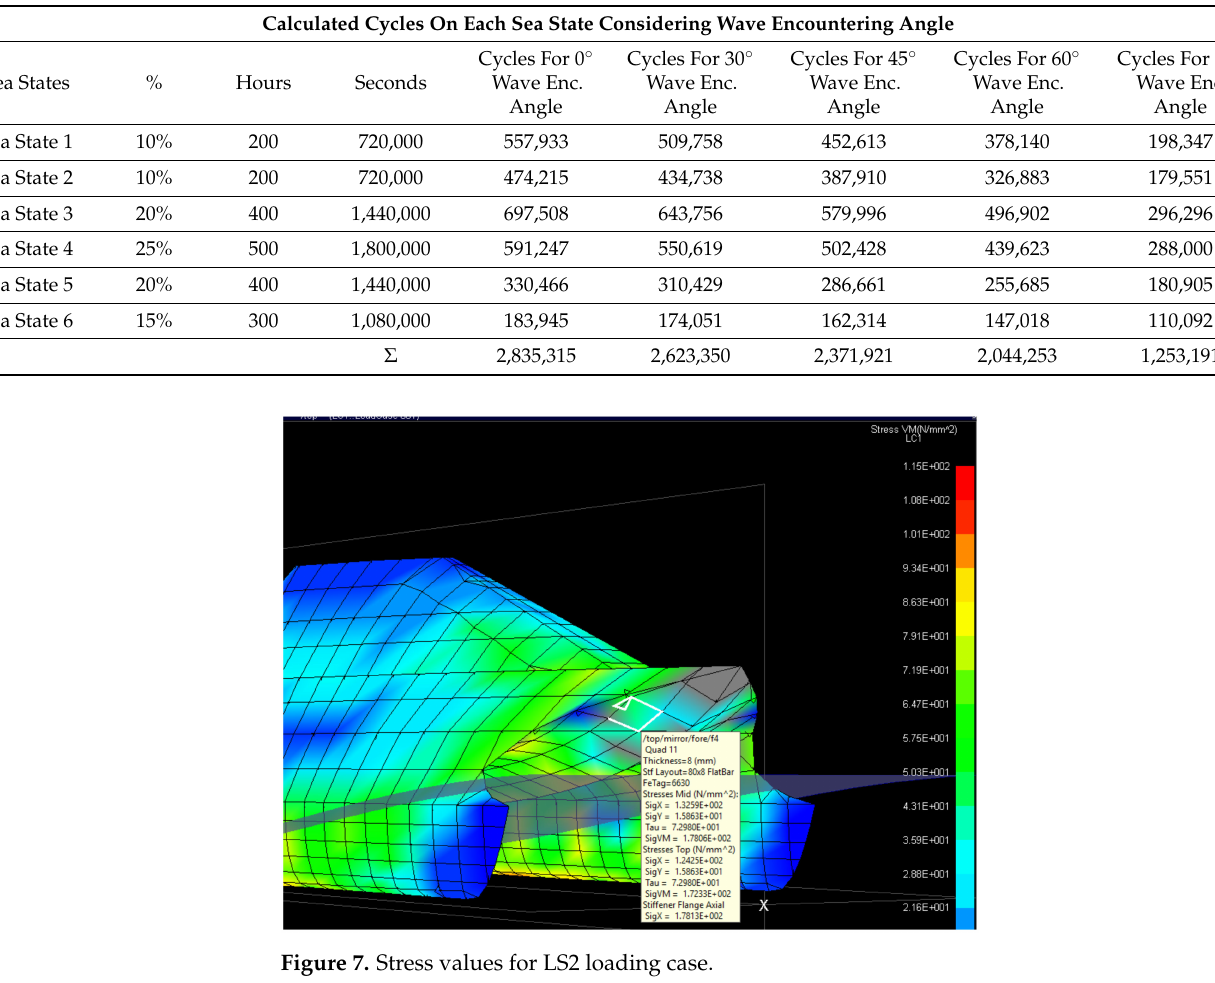
Table 11. Encounter cycle vs. sea state summary.